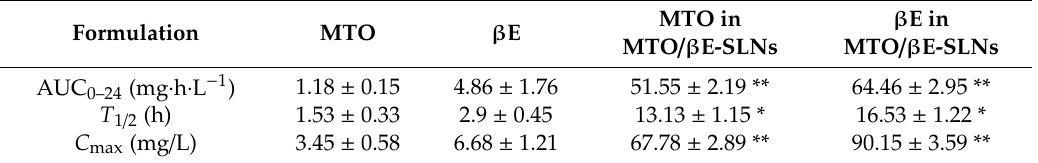
Table 4. Pharmacokinetic parameters of MTO and β E after intravenous administration of MTO, β E, and MTO / β E-SLNs in rats at a dose of 2 mg / kg for MTO and 4 mg / kg for β E ( n = 6). Formulation